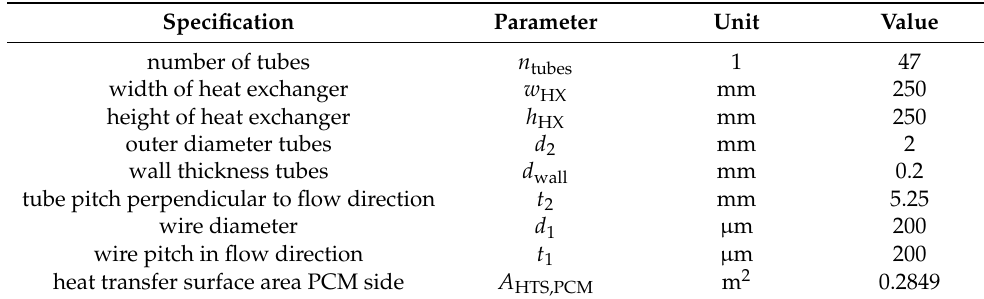
Table 1. Properties of the investigated wire cloth heat